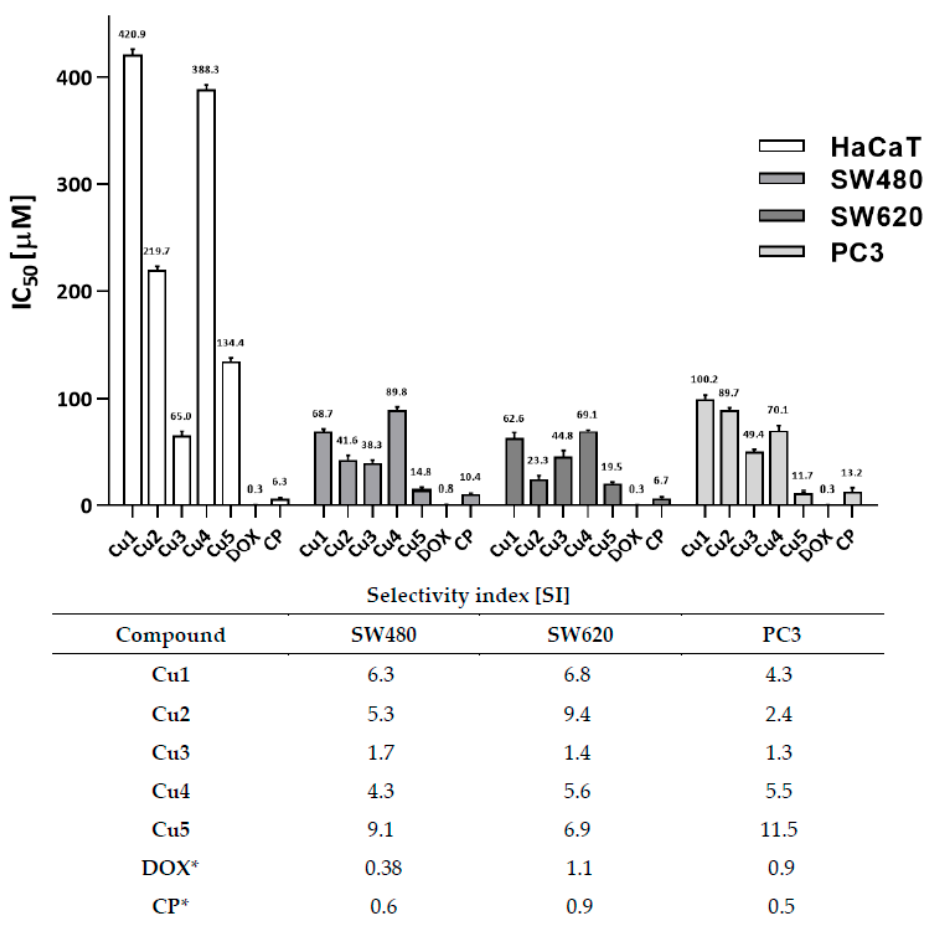
Figure 11. Cytotoxic activity (IC 50 , µ M) of studied compounds estimated by the MTT assay. Bars are expressed as mean SD, IC 50 ( µ M)—the concentration of the compound that corresponds to a 50% growth inhibition of the cell line (as compared to the control) after culturing the cells for 72 h with the individual compound. The SI (Selectivity Index) was calculated using the formula: SI = IC 50 for normal cell line/IC 50 cancer cell line. * The reference compounds: DOX—doxorubicin; CP—cisplatin.